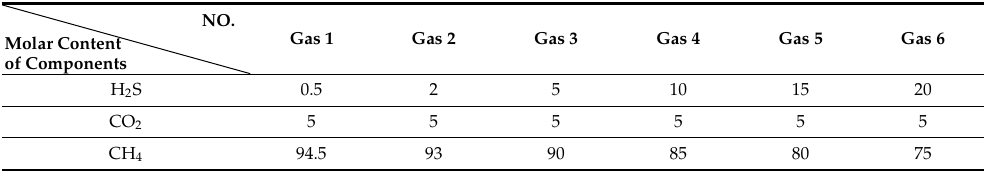
Table 3. High-sulfur natural gas mixture components.